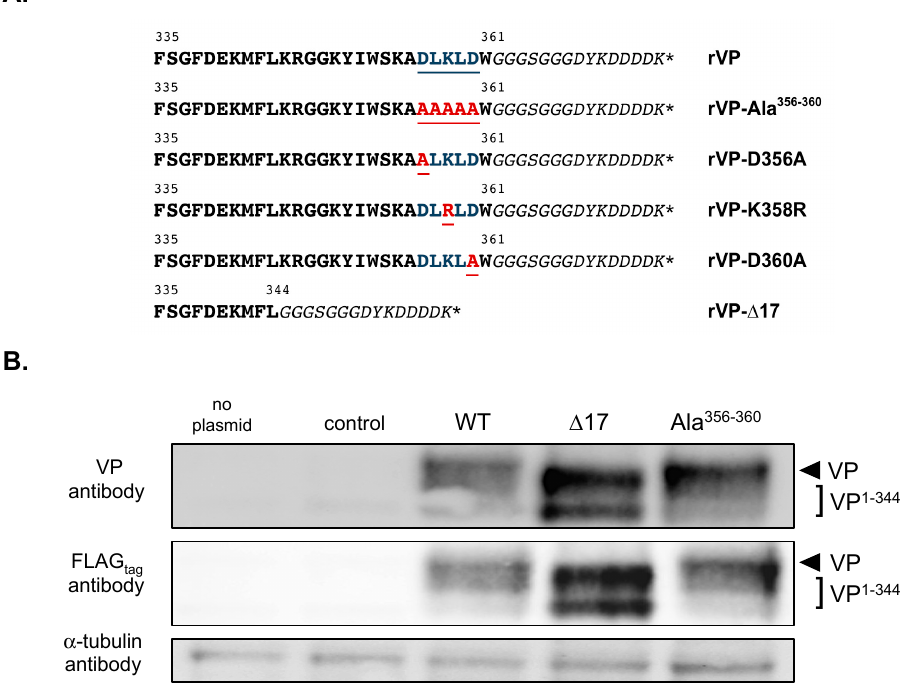
Figure 1. Analysis of rVP mutant expression in A549 cells. In ( A ), sequence alignment of the C-terminal part (VP-335 to VP-361) of recombinant human viperin (rVP wt ) and its mutants used in this study is shown. The five amino acid residues 356 to 360 mutagenized are highlighted in blue and underlined. The substitutions are highlighted in red and underlined. The glycine-serine spacer and the FLAG tag sequence adjacent to the C-terminus of rVP (W-361) are shown in italics. In ( B ), the analysis of rVP expression by immunoblot assay is shown. A549 cells were transfected at 18 h with pcDNA3/rVP (WT), pcDNA3/rVP- ∆ 17 (VP 1–344 ) or pcDNA3/rVP-Ala 356–360 (Ala 356–360 ). As controls, cells were transfected with pcDNA3/RenLUC (control) or mock-transfected (no plasmid). The α -tubulin protein served as a protein loading control.